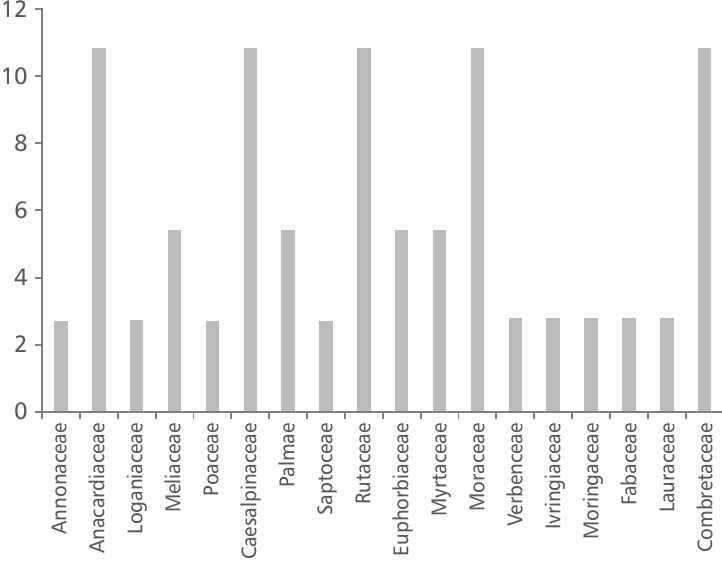
FIGURE 2. Diversity of ethno-medicinal trees in built up areas of University Park, University of Port Harcourt, Nigeria